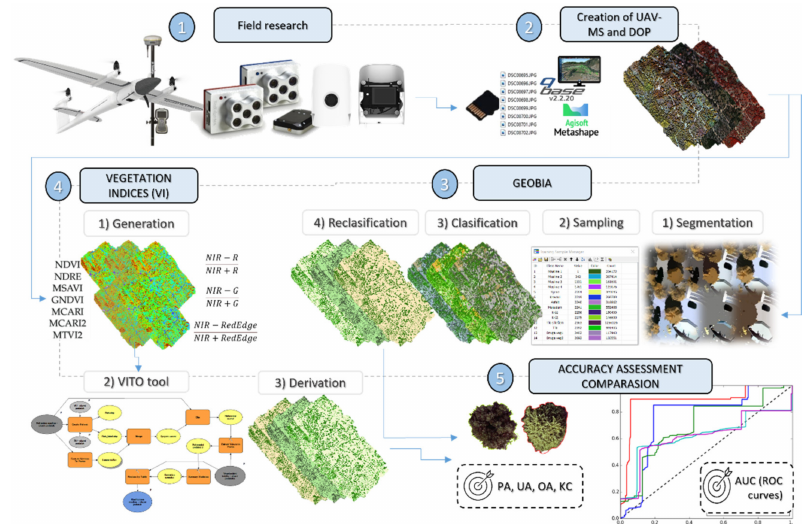
Figure 2. The research methodology framework.